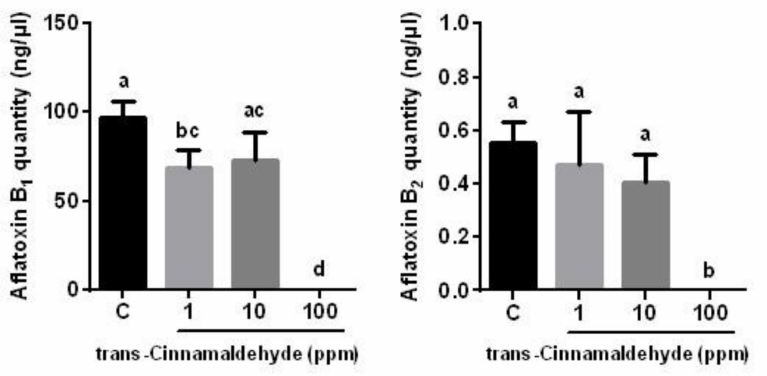
Figure 3. Effects of t -cinnamaldehyde on aflatoxin production by Aspergillus flavus . AFB 1 , aflatoxin B 1 ; AFB 2 , aflatoxin B 2 . Different letters above the same column indicate significant differences among the treatments. Data are presented as the mean ±